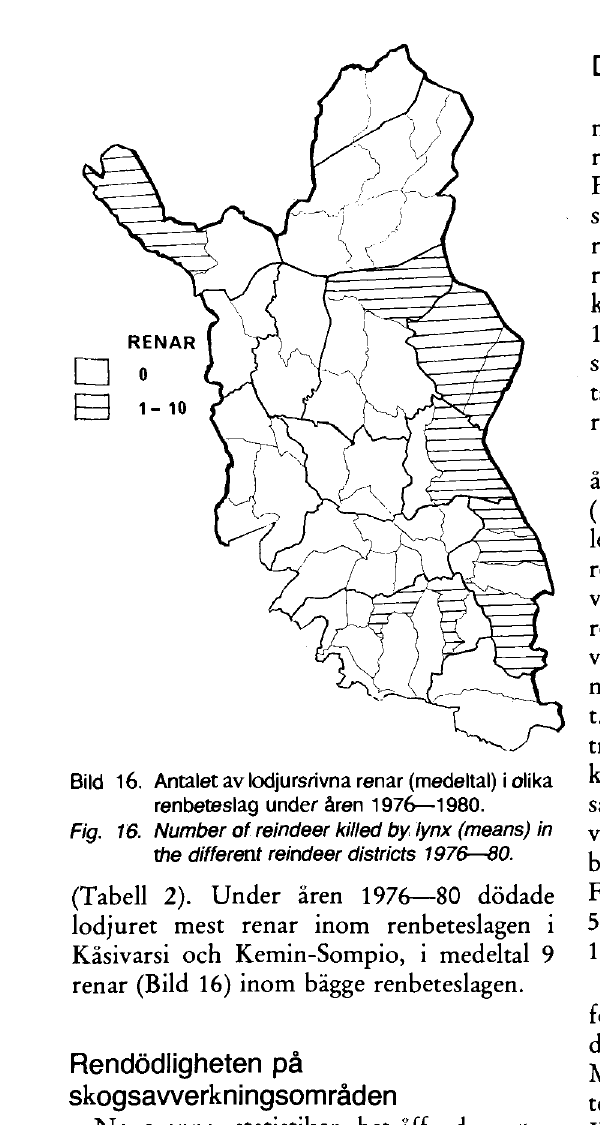
Fig. 16. Number of reindeer killed by lynx (means) in the different reindeer districts 1976—80. (Tabell 2). Under åren 1976—80